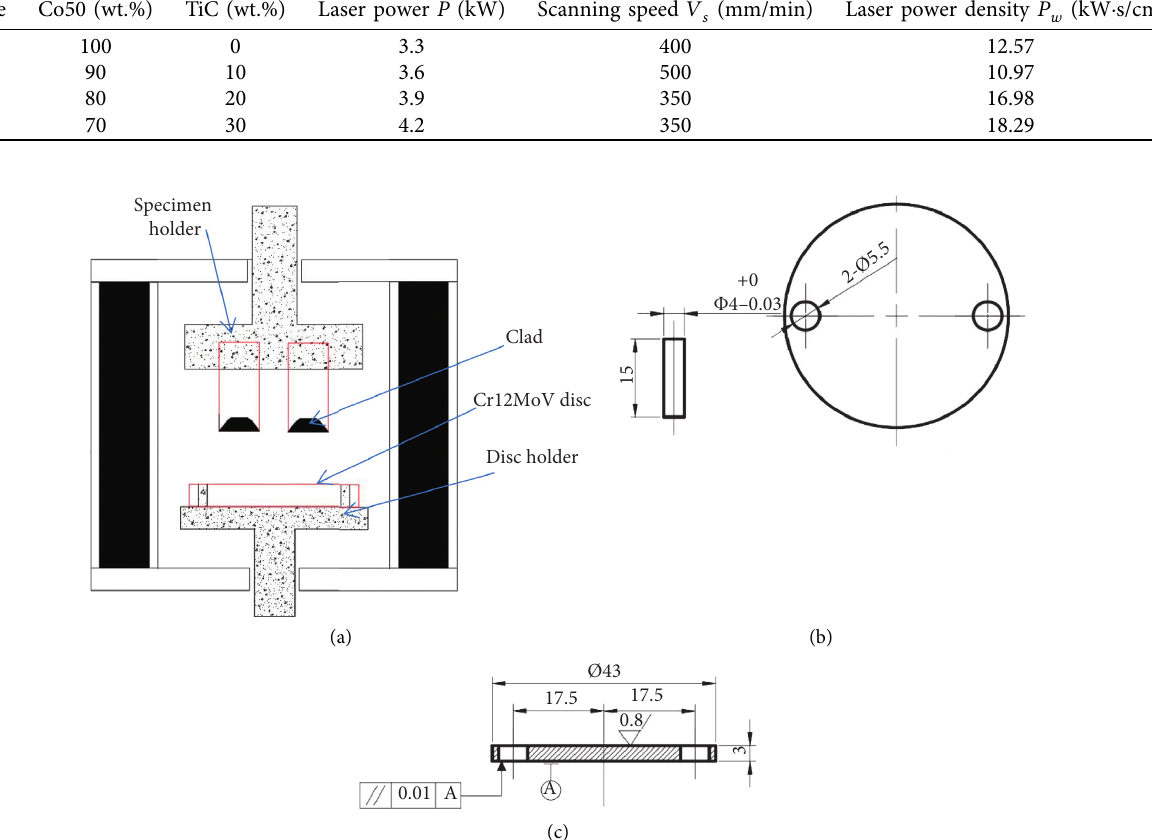
Figure 1: Pin-on-disc wear of friction pairs and friction testing samples: (a) MMU-5G high-temperature wear tester and its principle; (b) upper specimen; (c) friction